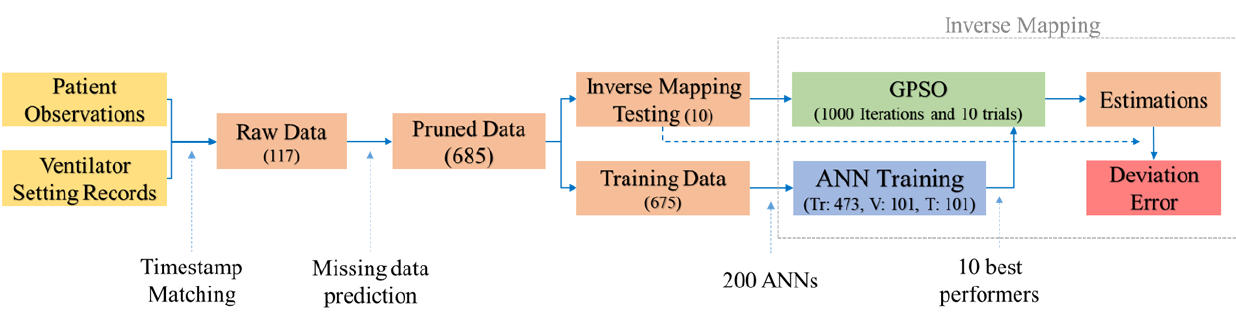
Figure 4. Block diagram shows a summary of data flow and operations carried out on the data at different